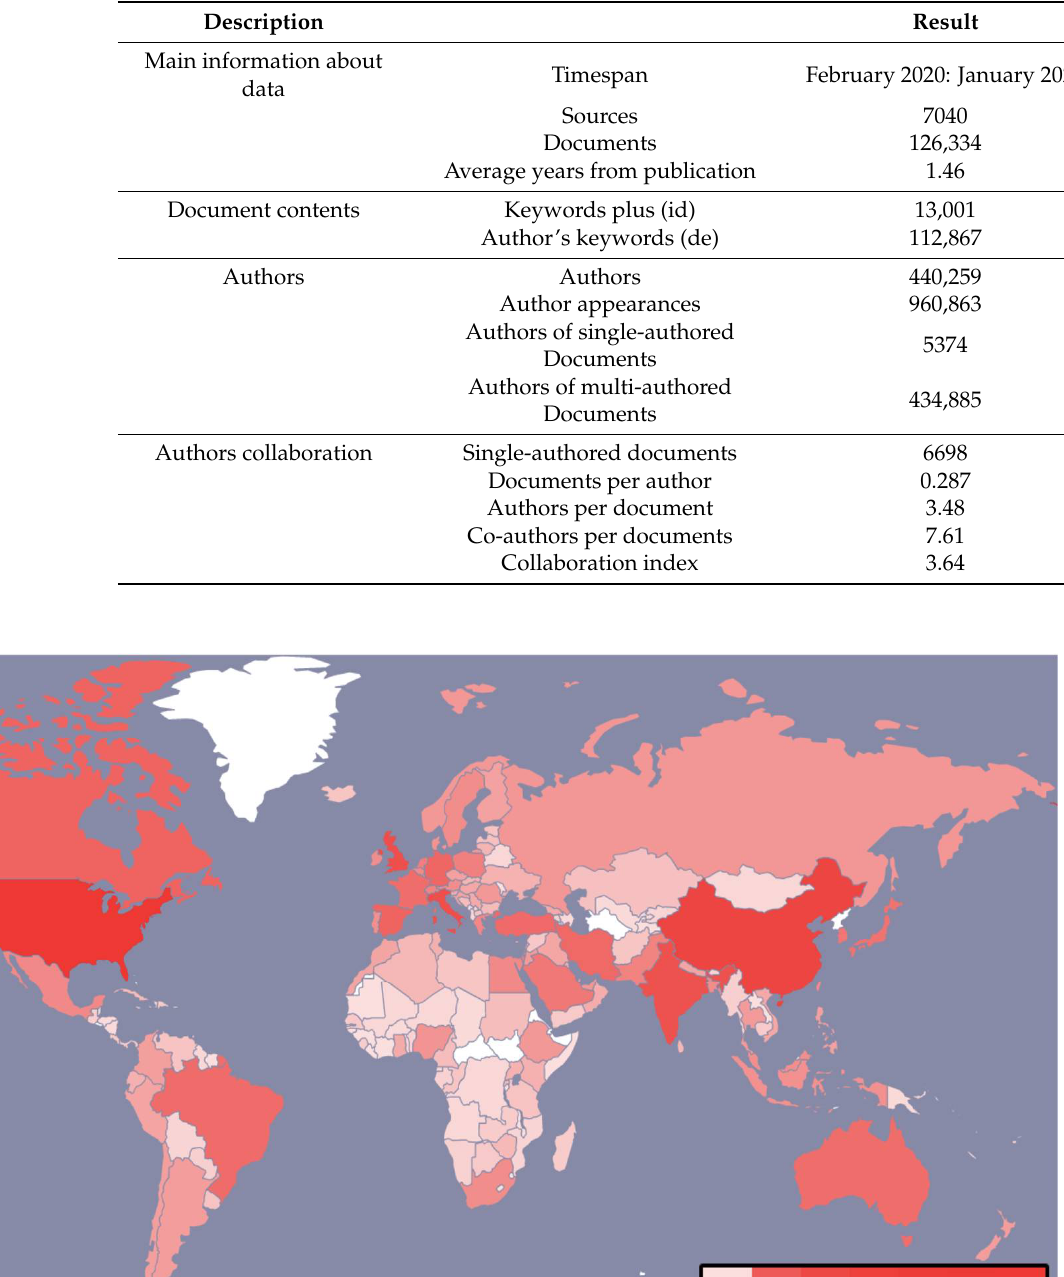
Table 1. Main statistics about the COVID-19 collection.